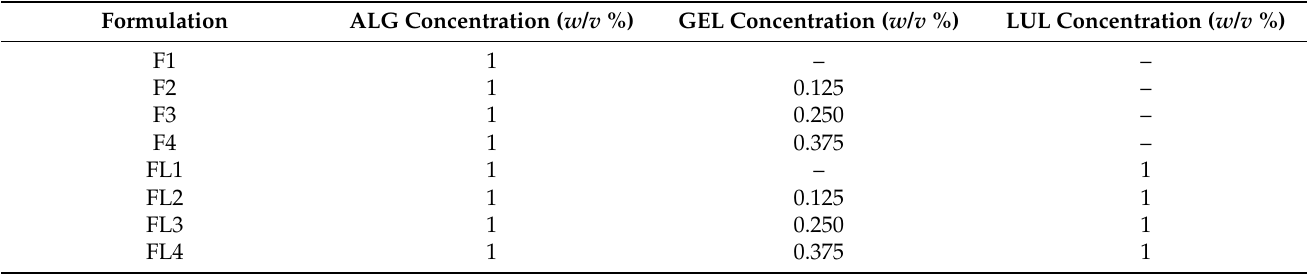
Table 1. Constitution of ALG/GEL